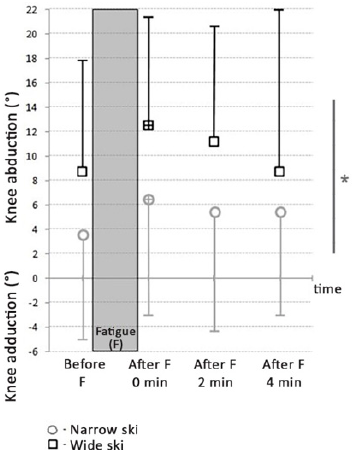
Figure 4. Knee abduction / adduction in a prefatigued state (before F) and at di ff erent times after fatigue (after F) with two di ff erent ski waist-widths. + depicts statistically significant di ff erence compared to prefatigued state ( p < 0.05); * depicts statistically significant di ff erence between all-narrow against all-wide waist-width